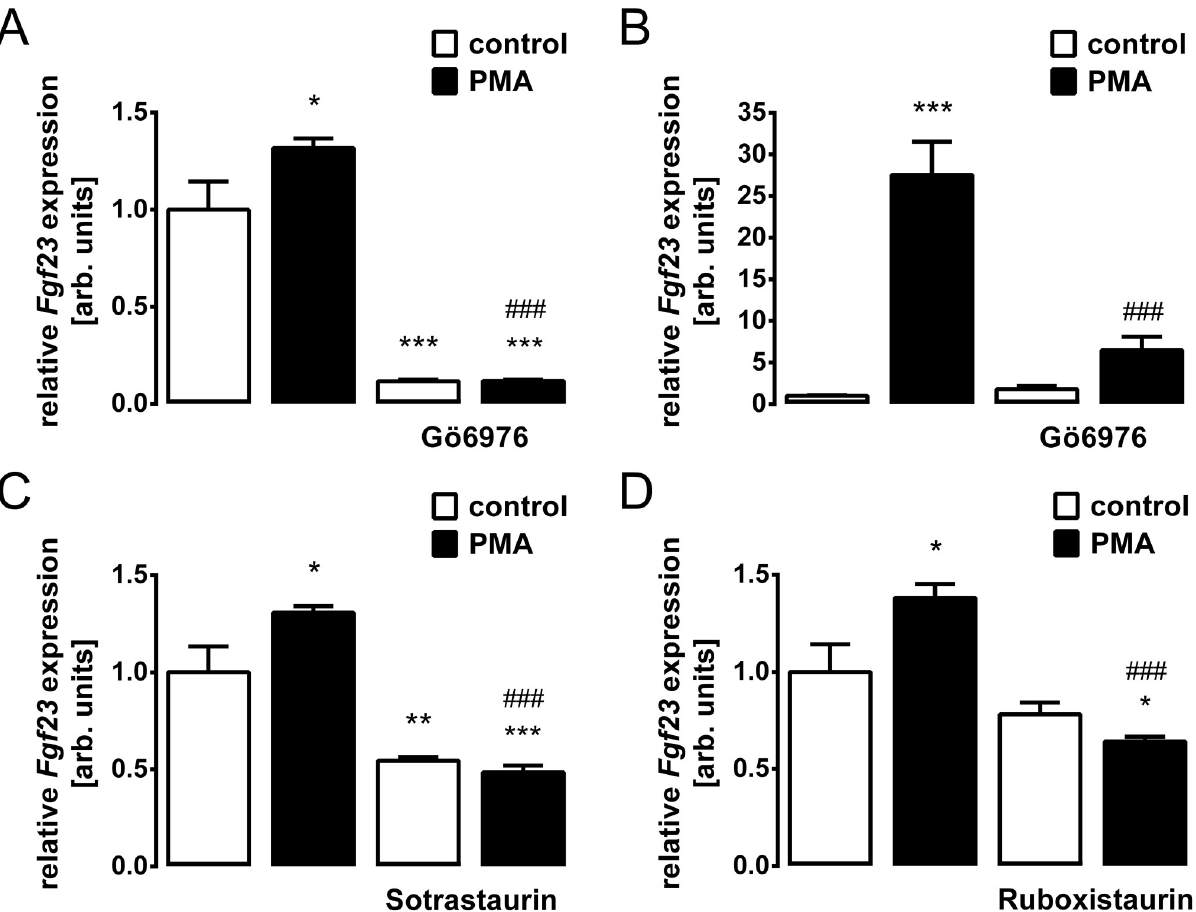
Fig 4. PKC inhibition abrogates the PMA-induced increase in Fgf23 gene expression in UMR106 osteoblast-like cells and in IDG-SW3 osteocytes. Relative Fgf23 transcript levels in UMR106 cells ( A,C,D ) or in IDG-SW3 cells ( B ) incubated without or with PMA (0.1 μ M, A-D ) in the absence and presence of PKC α / β inhibitor Go¨6976 (1 μ M, A,B ), pan PKC inhibitor Sotrastaurin (1 μ M, C ) or PKC β inhibitor Ruboxistaurin (1 μ M, D ). Gene expression was normalized to Tbp as a housekeeping gene, and the values are expressed as arithmetic means ± SEM (n = 6). � p < 0.05, �� p < 0.01, and ��� p < 0.001 indicate significant difference from vehicle (first bar). ### p < 0.001 indicates significant difference from the absence of PKC inhibitor (second bar vs. fourth bar). arb., arbitrary.